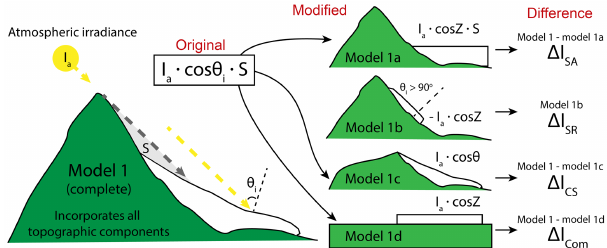
Figure 3. Diagram illustrating the derivation of Eqs. (3)–(6). Model 1 (same as Eq. 2) is the base model and incorporates both methods of topographic shading ( S ) and the effect of slope and as- pect ( θ i ). Additional models are also created, each excluding some component of topography. The difference between model 1 and model 1a shows the change in irradiance due to slope and aspect on the surface of the glacier. Model 1b calculates the sum of irra- diance that would arrive on a flat surface at locations on the glacier where the incidence angle ( θ i ) is greater than 90 ◦ . Model 1b is the only scenario not dependent on model 1. The difference between model 1 and model 1c shows the change in irradiance due only to cast shadows. Model 1d removes surrounding terrain and assumes the glacier surface is a flat plane, the difference between this and the original model shows the combined effect of removing all topo- graphic information from the